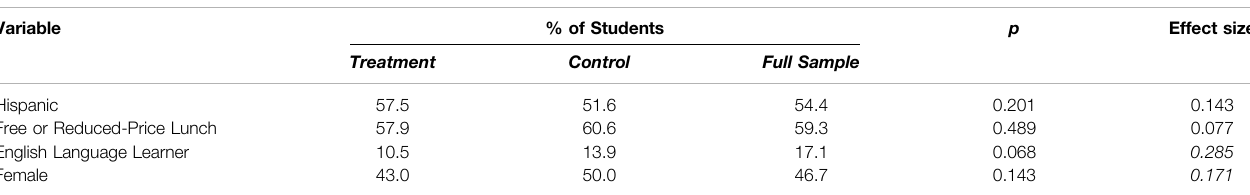
Table 3 | Student demographic information for teacher-rated impact sample by condition Variable